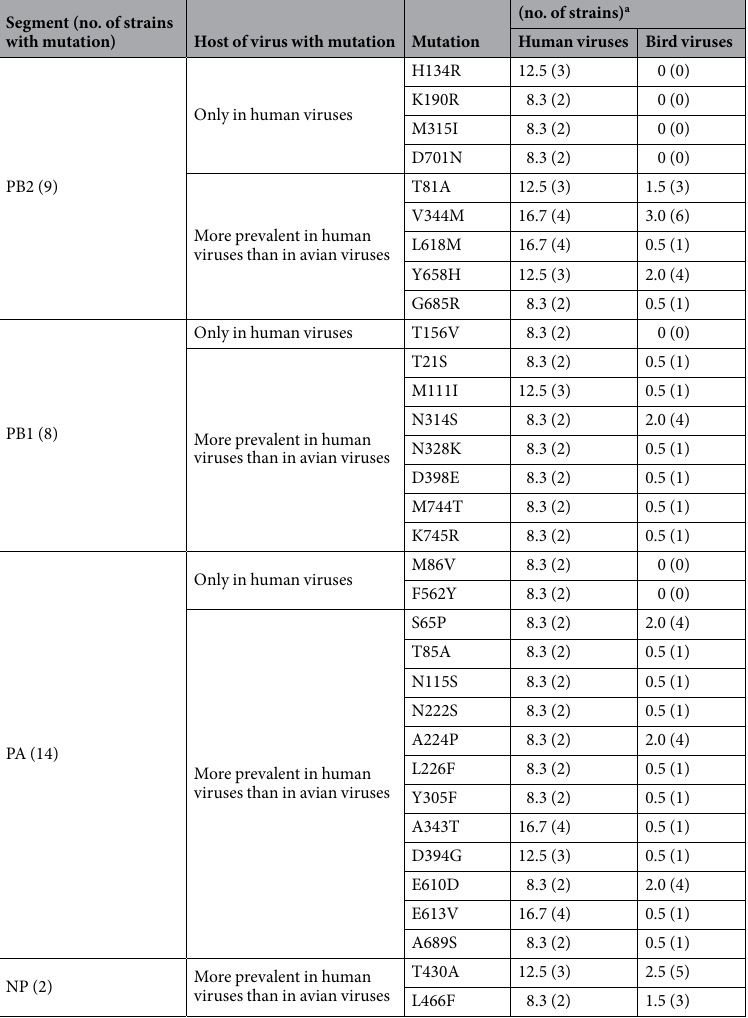
Table 1. Prevalence of H5N1 polymerase mutations in human and avian viruses identified in the database search in this study. a The sequences of 24 human virus strains and 198 avian virus strains isolated in Southern China, Vietnam and Cambodia during 2008–2012 and in the NCBI Influenza Virus Resource were used in this